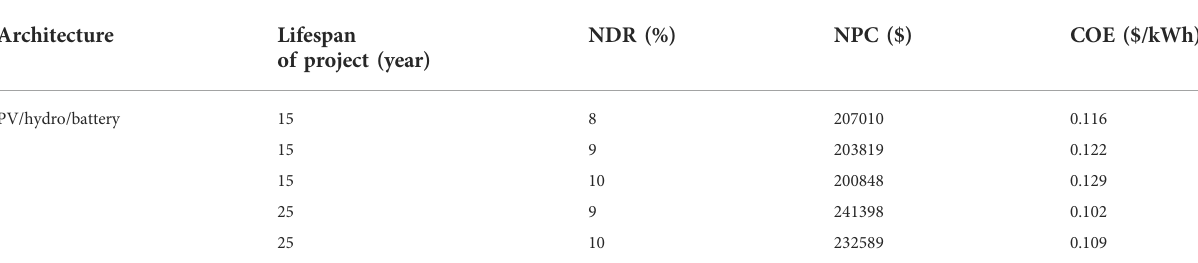
TABLE 4 Impact of NDR and project lifetime on the system.